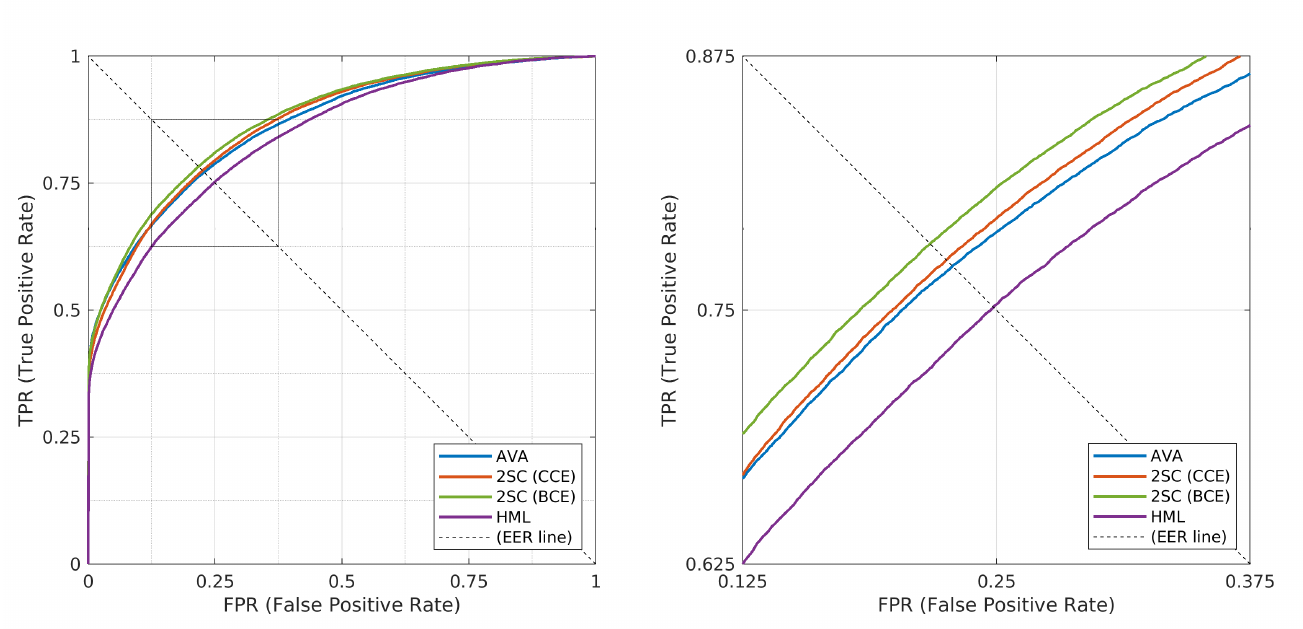
Figure 7. Macro-average ROC curves for different classification approaches on our revisited CompCars dataset at the finest level of classification (make–model–year). The Equal Error Rate line (EER) is also visualized.